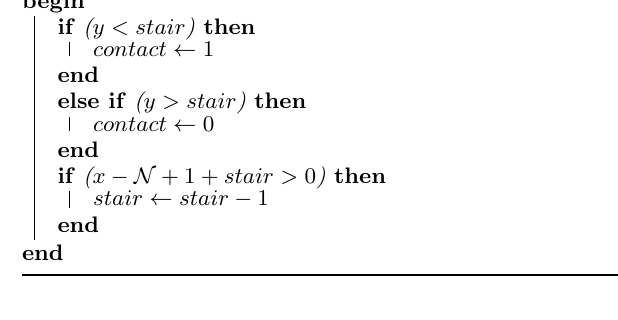
Figure 3: Variation of communication step size during pro- cessing of discrete event.